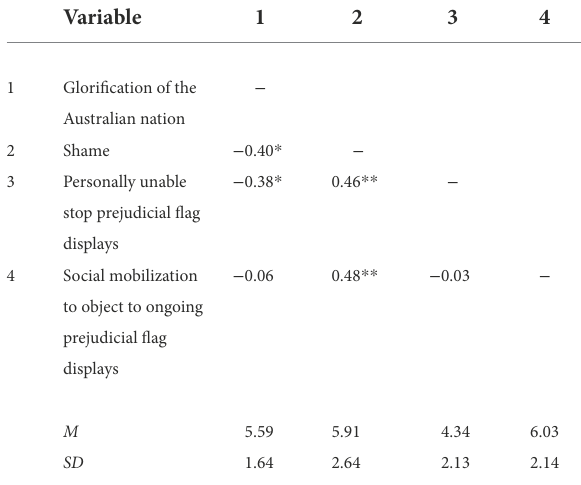
TABLE 1 Scale inter-correlations and descriptive